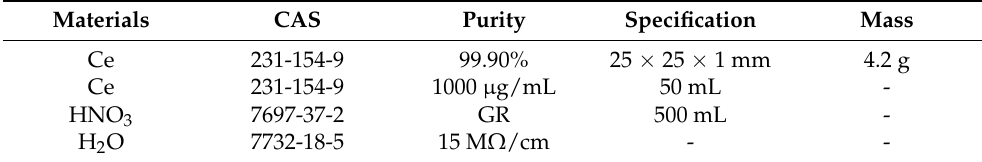
Table 4. Materials of the experiment.